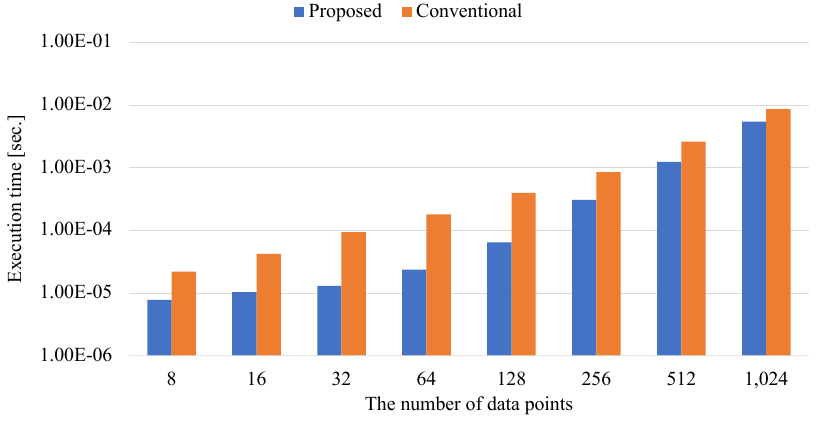
Figure 9. The execution time of determining the Gaussian kernel coefficients.